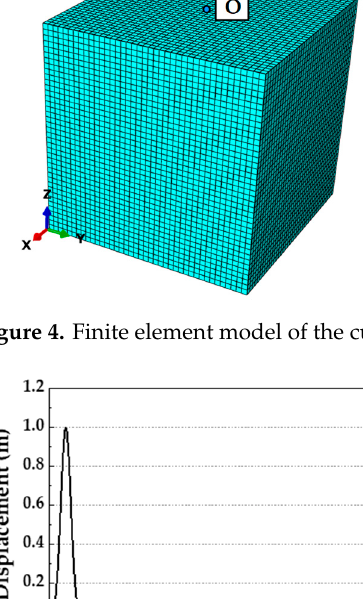
Figure 5. The input P wave displacement time-history curve.